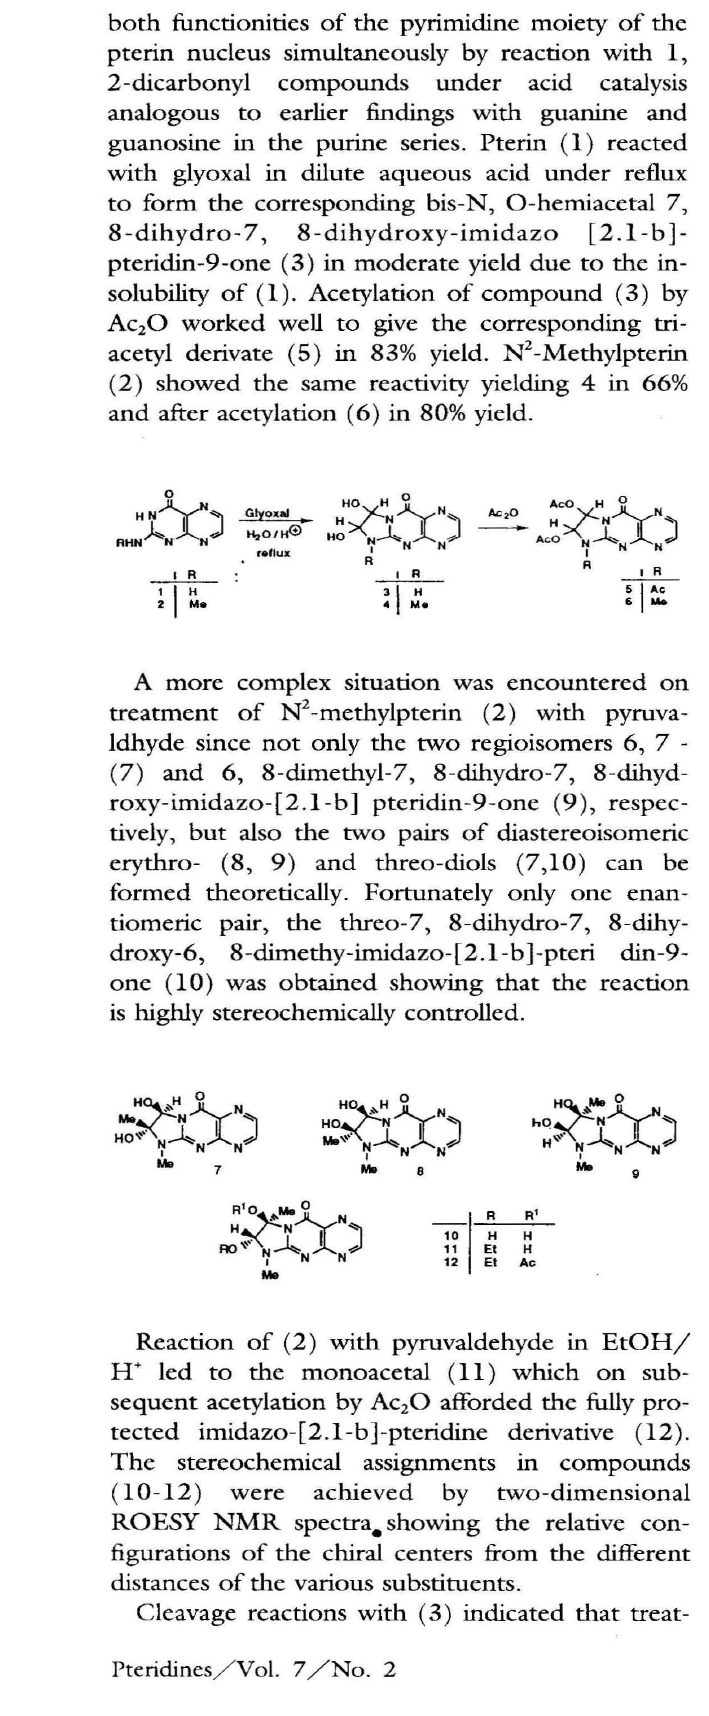
figurations of the chiral centers from the different distances of the various substituents. Cleavage reactions with (3) indicated that treat- Pteridines/ Vol. 7/ No.